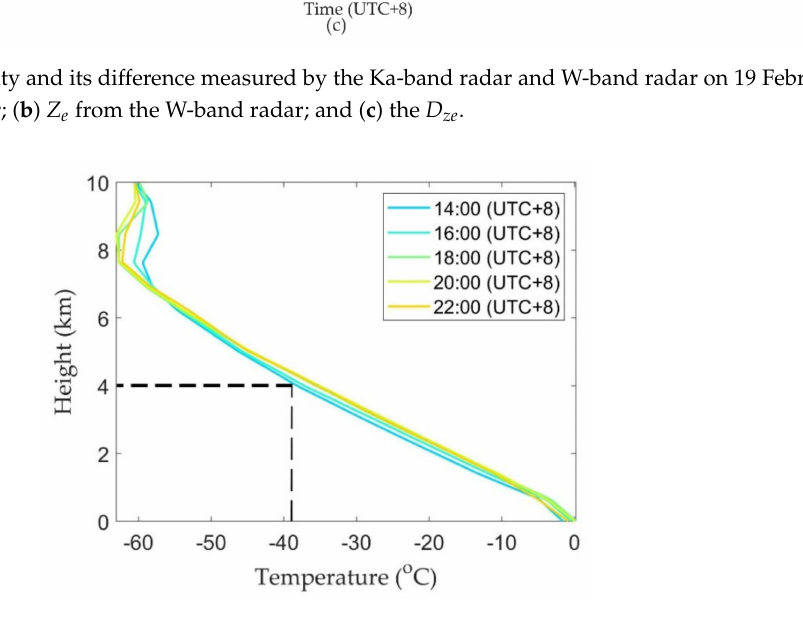
Figure 13. Profiles of temperature from 1400 to 2200 (UTC + 8) every two hours on 19 February